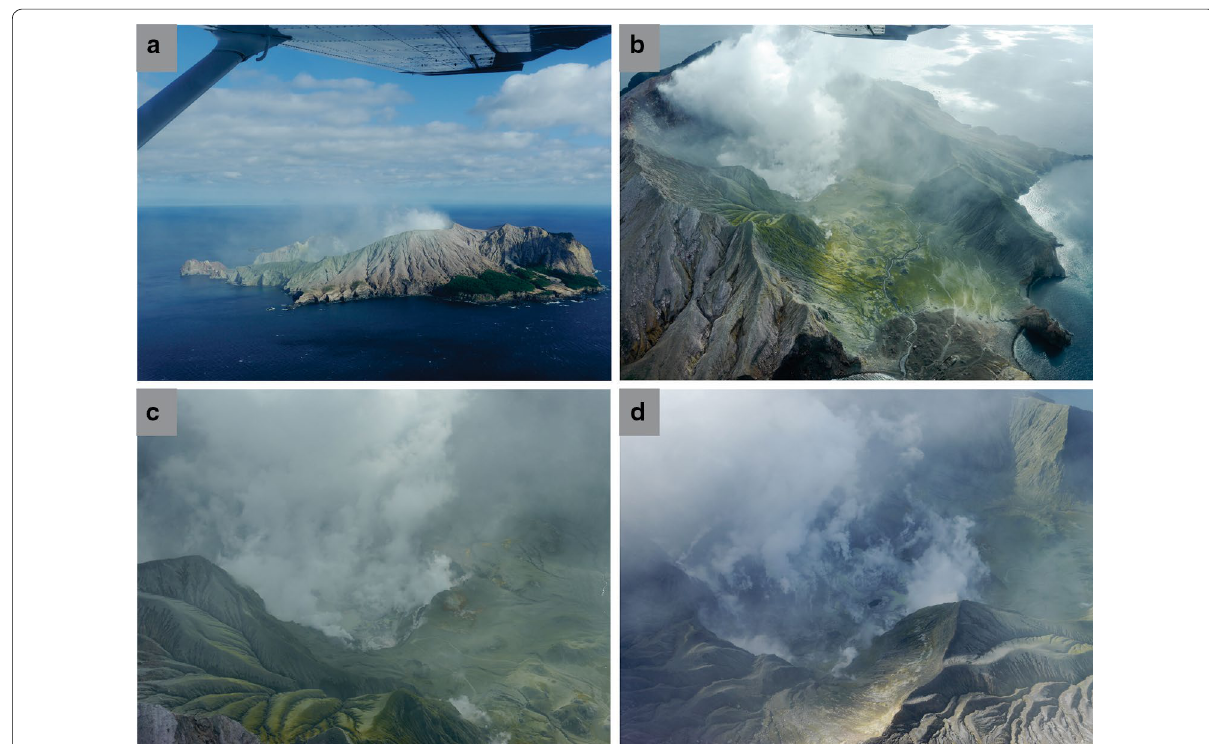
Fig. 2 Aerial photographs taken of the island on the 29 April 2016. a View to the south showing ash distribution on the northern crater wall. b View of the main crater floor showing the distribution extent of the pyroclastic surge (yellow-green coloured) to the bottom right of the image. c Image of the eastern edge of the vent area and with high altitude ash deposition in the immediate foreground. d Inner crater image showing the extensive steaming ground and the diffuse emission sources. This inner crater area is usually submerged beneath a hot, acidic crater